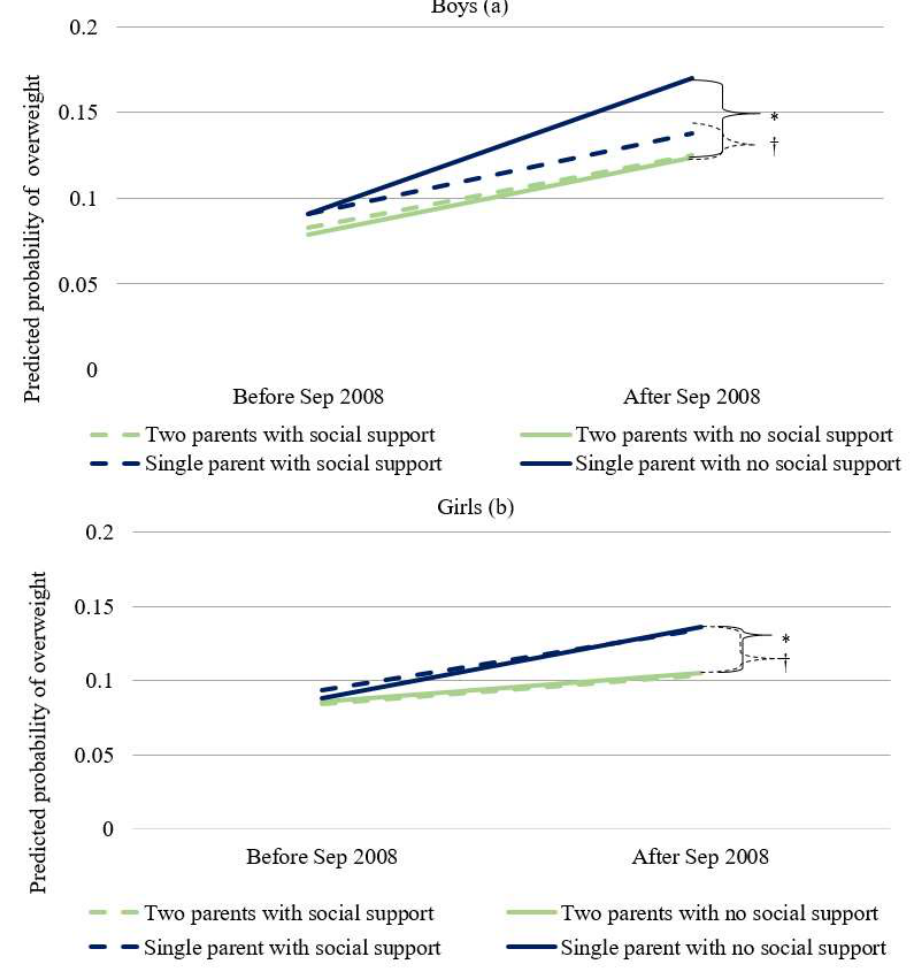
Figure 3. Difference in predicted overweight prevalence before and after the 2008 global financial crisis by parental status and parental reception of social support ( a ) among boys and ( b ) among girls. * p -Value for slope difference (with no social support): boys = 0.098, girls = 0.049, † p -Value for slope difference (with social support): boys = 0.908, girls = 0.140.